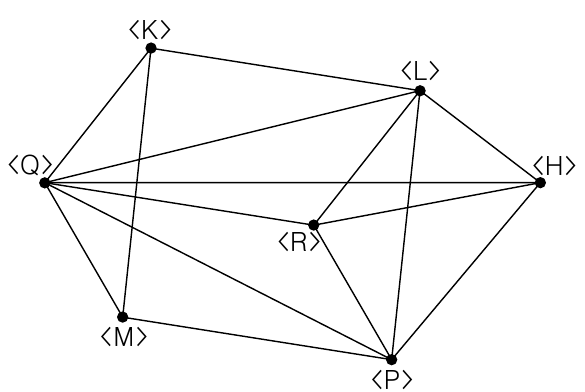
Figure 10 . Sp( N ) = U( N ), N = 4 m . Vertices, line segments and triangular faces correspond to vacua, walls and three-pronged